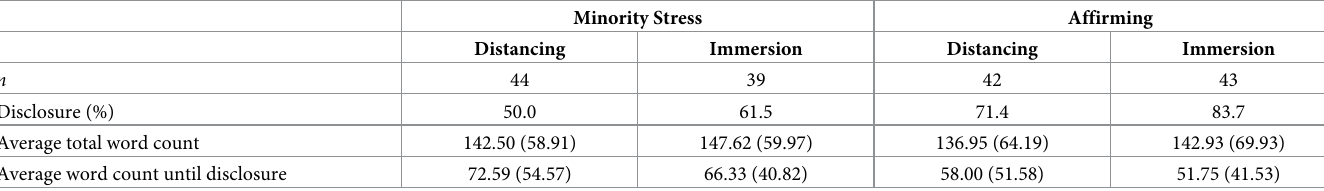
Table 2. Descriptive characteristics of disclosure variables by film and emotion regulation